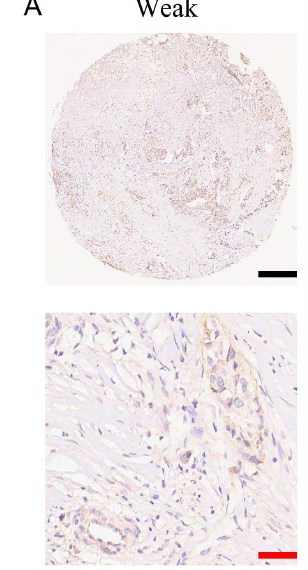
Figure 3. Representative image of IHC staining for KRT17 in the BC TMA. ( A ). Weak, moderate and strong staining of KRT17 in HER2 high BC tissues. ( B , C ) OS of the KRT17 high and KRT17 low expression groups in HER2 high and HER2 low BC patients, respectively. Black bars: 600 µ m; Red bars: 200 µ